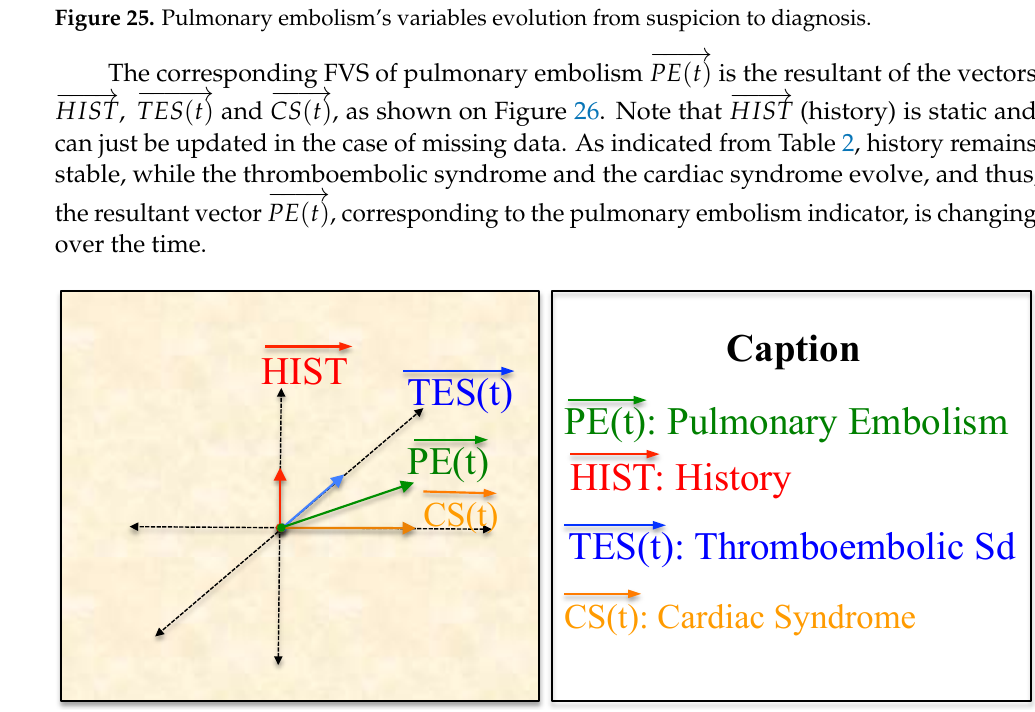
Figure 26. Pulmonary embolism’s